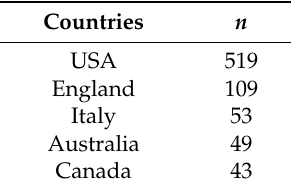
Table 8. Most productive countries in terms of ASD-TECH